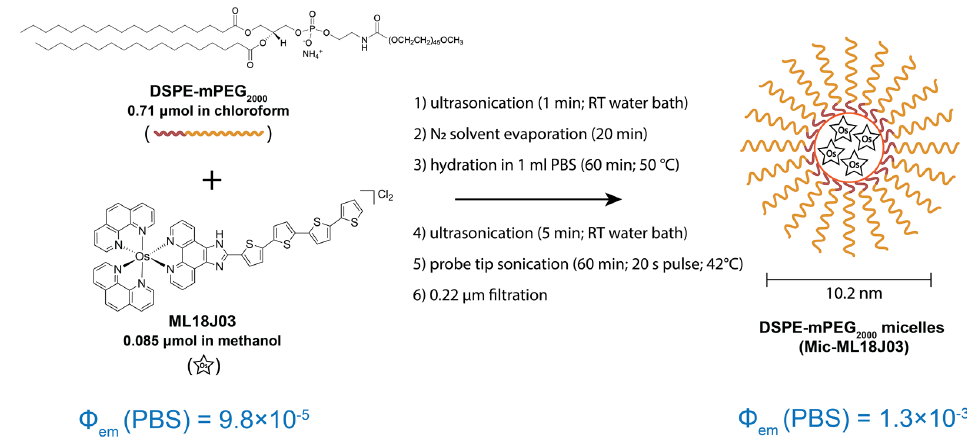
Figure 1. Diagrammatic representation of the formulation of ML18J03 into DSPE-mPEG 2000 micelles in order to increase their luminescence quantum yield in aqueous environments and enable in vivo optical imaging.